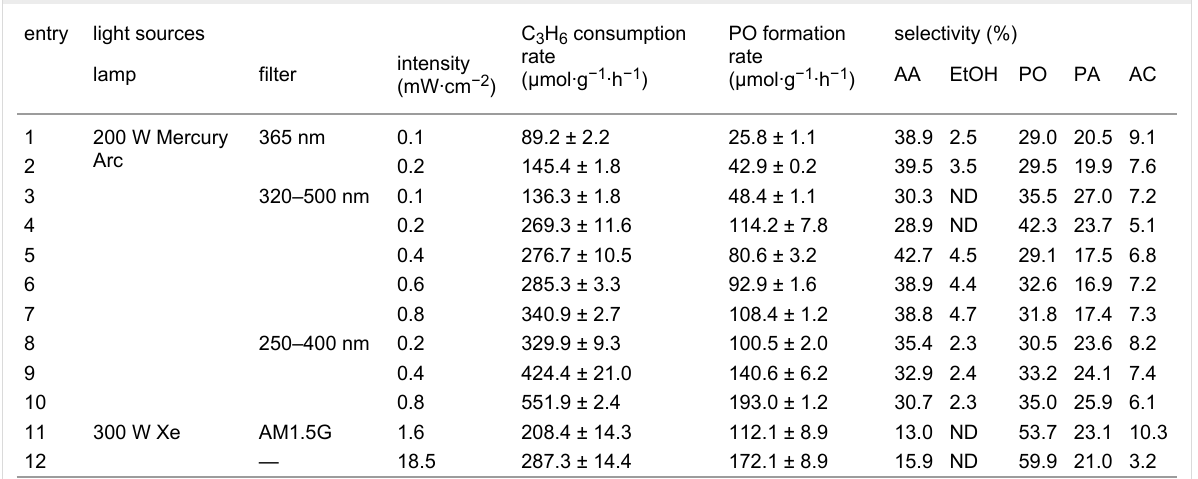
entry light sources